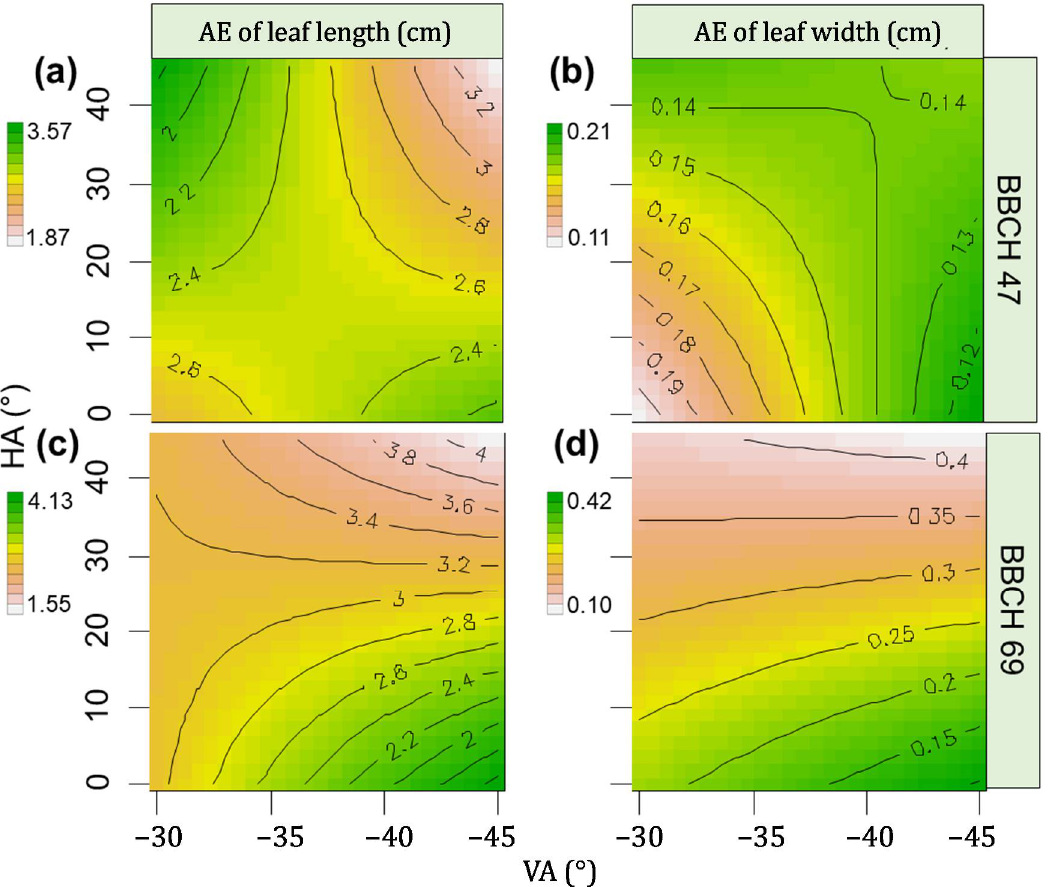
Figure 10. Response surface contour plots shows the two-factor interaction of vertical angle (VA, °) and horizontal angle (HA, °) on the absolute error (cm) of the parameters ( a ) length and ( b ) width at the BBCH 47 and ( c ) length and ( d ) width at the BBCH 69.